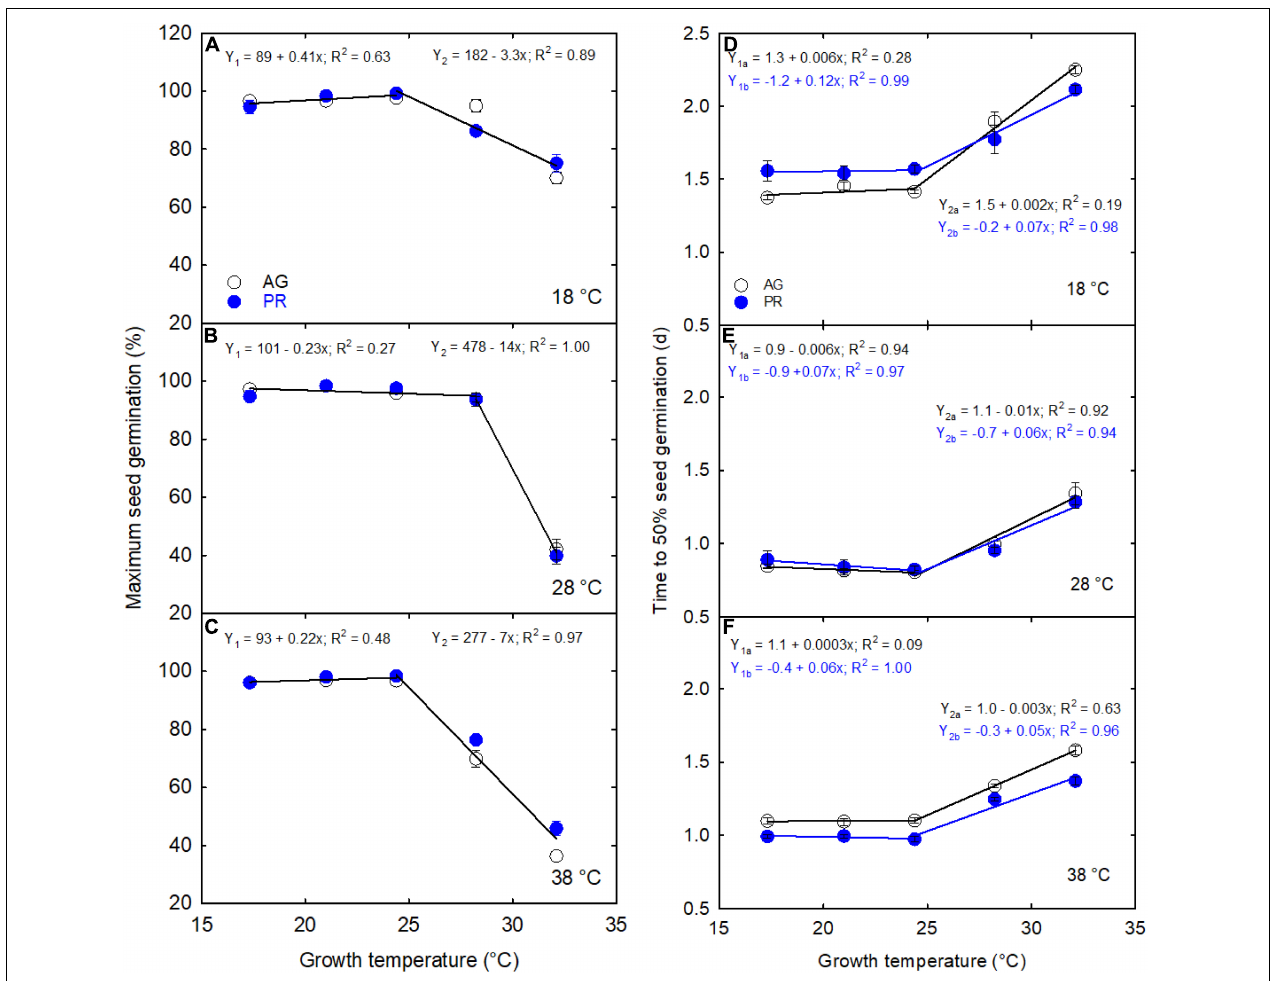
FIGURE 7 | The effects of parental growing temperatures on next-generation maximum seed germination (A–C) and time to reach 50% germination (E–F) of AG and PR